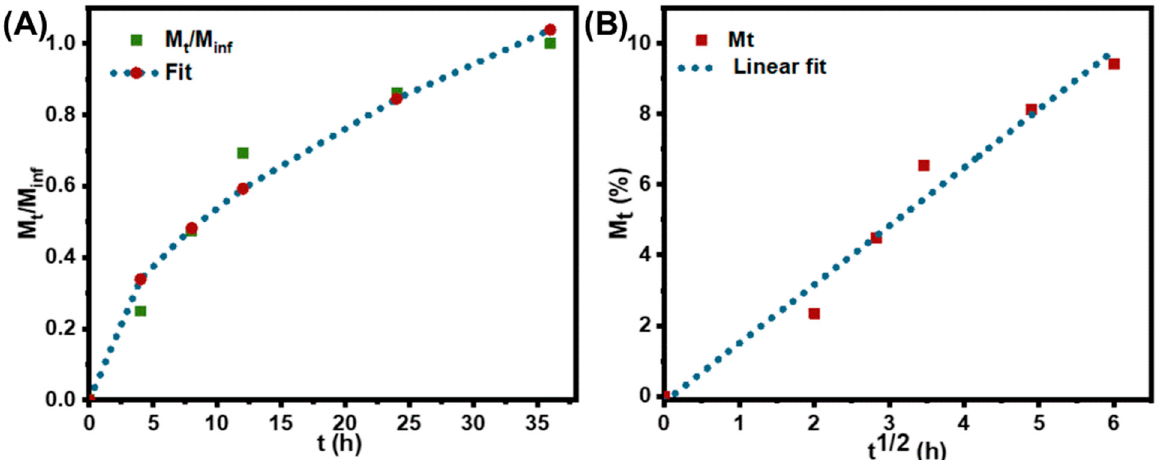
Figure 4. Fitting of cumulative % drug release data to ( A ) Ritger–Peppas and ( B ) Higuchi model for pH 7.4.